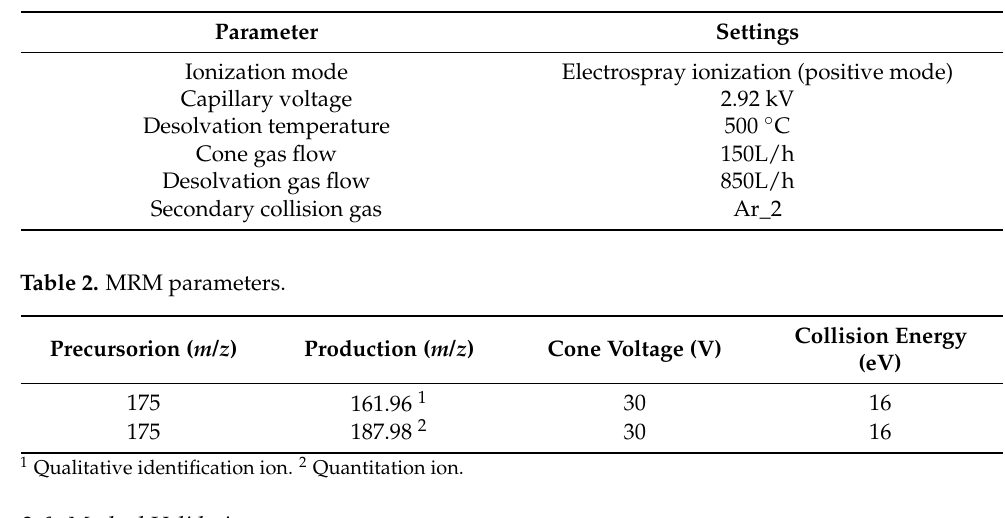
Table 1. MS parameters.